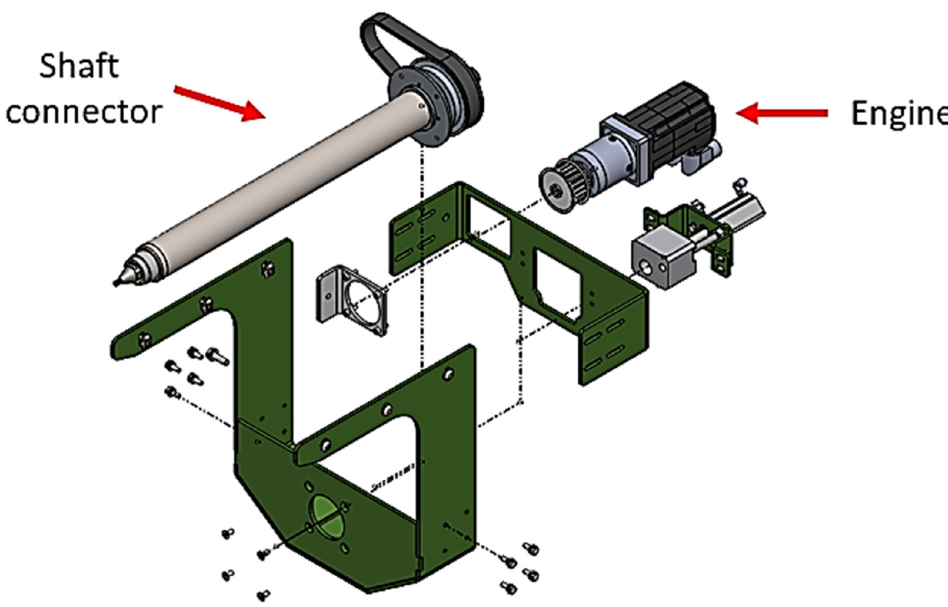
Figure 6. “Coil Holder” assembly’s exploded view.